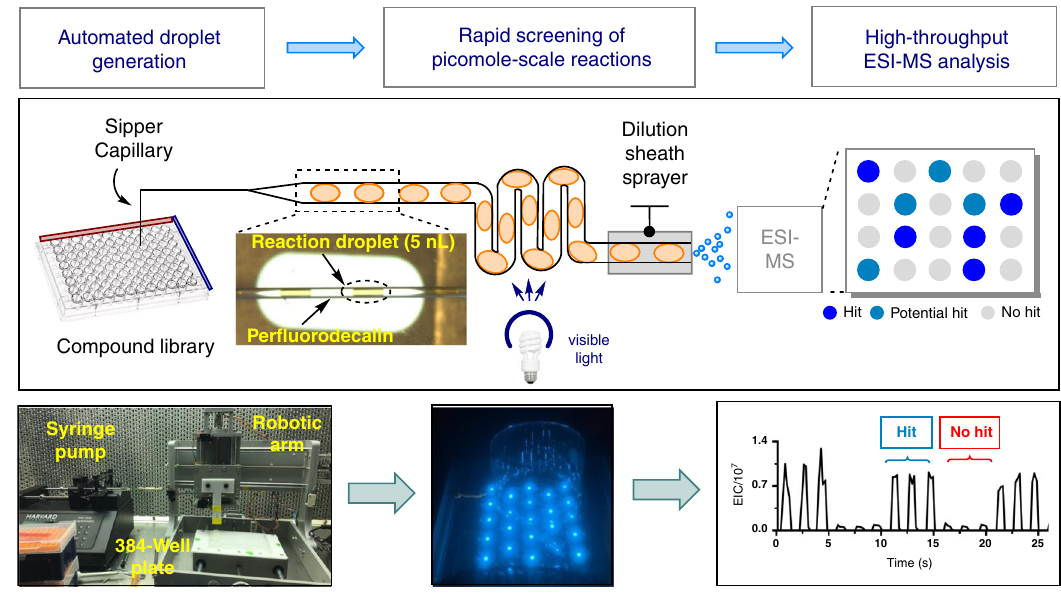
Fig. 1 Development of a photochemical droplet micro fl uidics platform. EIC extracted ion chromatogram, ESI-MS electrospray ionization-mass